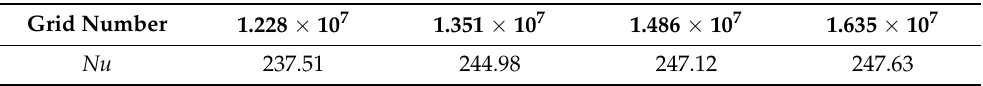
Table 3. Results of different grid numbers.